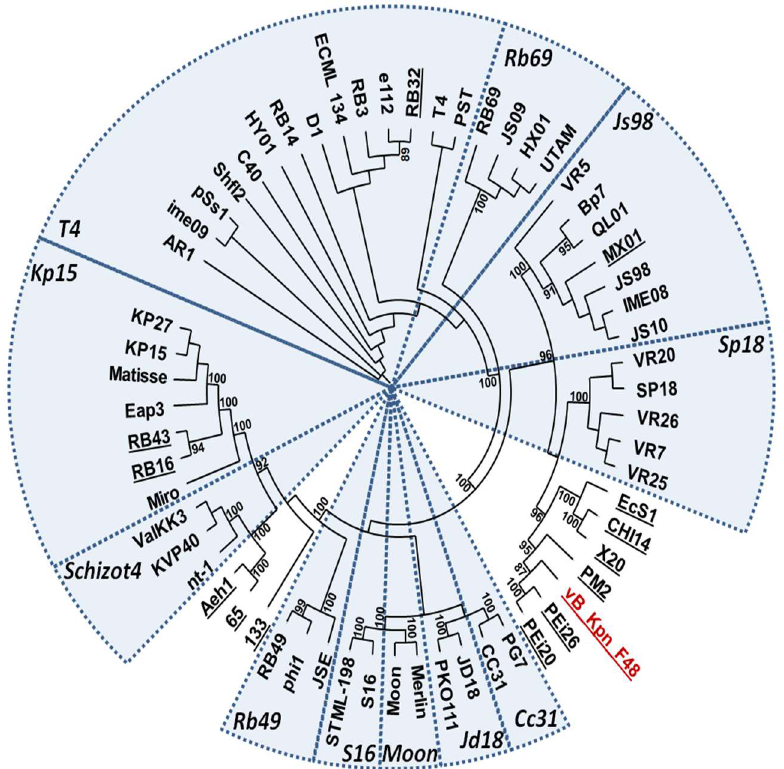
Figure 7. Phylogenetic tree of large subunit terminase of vB_Kpn_F48 (red) and homologues proteins of other members of the Tevenvirinae subfamily. Distinct genera are highlighted by circular sectors. Phages not assigned to specific genera by the ICTV classification (accessed 19 April 2018) are underlined. Bootstrap values ≥ 85% are indicated.